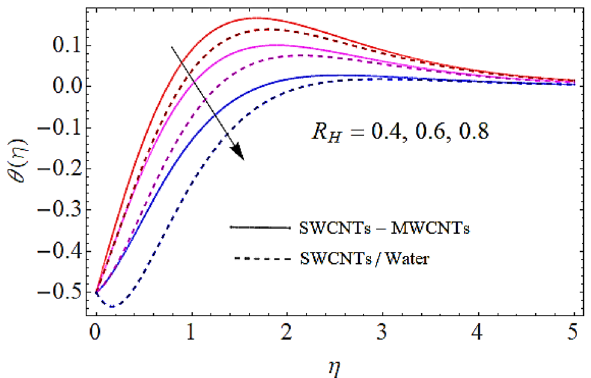
Figure 9. Thermal profiles versus R H when M = 0.5, (cid:31) = 0.3, φ 1 = φ 2 = 0.02, K = 0.7, Pr = 12 .